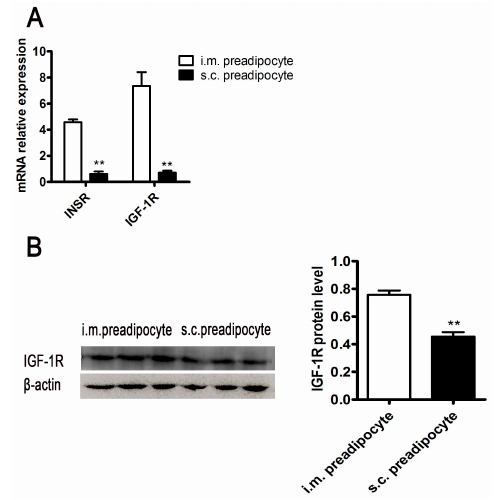
Figure 2. Downregulation of insulin receptor ( INSR ) or IGF-1 receptor ( IGF-1R ) by siRNA interference decreased porcine adipocyte differentiation. The siRNAs targeting INSR and IGF-1R (si-INSR, si-IGF-1R) were transfected into porcine s.c. preadipocytes. The INSR / IGF-1R mRNA ( A ) ( n = 6) and protein levels ( B ) ( n = 3) were verified after transfected with siNC and si-INSR/si-IGF-1R at 24 and 48 h, respectively; Transfected s.c. preadipocytes were induced to differentiate for nine days; The intracellular accumulation was determined by cytoplasm triglyceride content ( C ) ( n = 4) and Oil Red O staining ( D ) ( n = 3). The mRNA expression differences were normalized to Ribosomal protein lateral stalk subunit P0 ( RPLP0 ) mRNA level. The β -actin bands served as an internal control for protein loading. ** p < 0.01, Scale bar = 200 µ m.